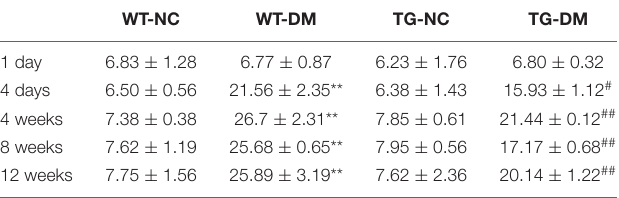
TABLE 2 | Blood glucose test results for each group of mice